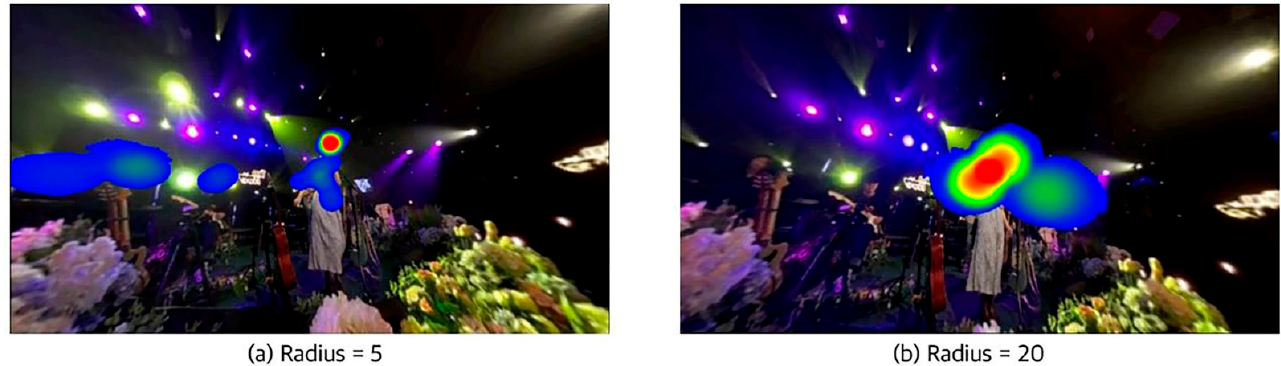
Figure 10. The 360-degree VR eye-tracking system measurement results. ( a ) The original video ( b ) The result of the users’ eye-tracking heatmap data.